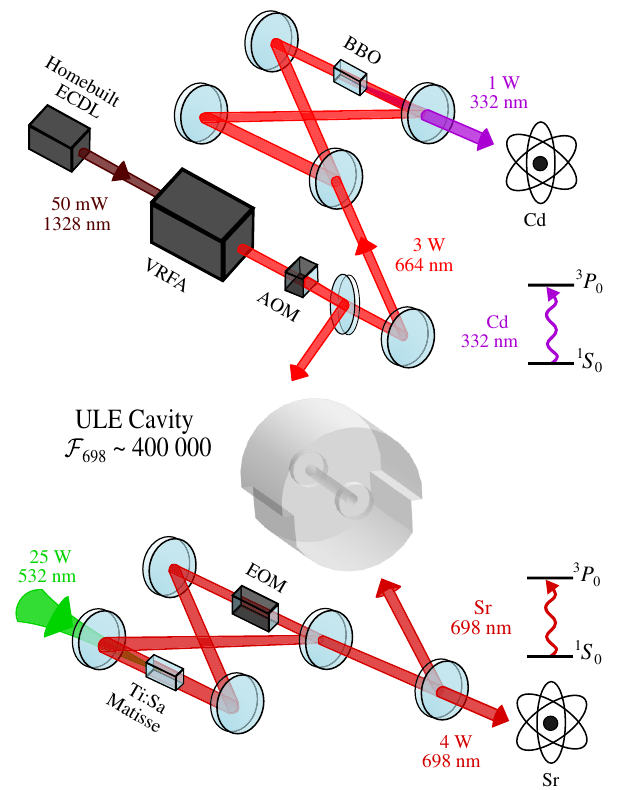
FIG. 4. The setup of the clock atom interferometry laser sources for Sr and Cd at 332 nm and 698 nm, respectively. The laser for Sr is derived from a Ti:sapphire laser with an intracav- ity EOM. For Cd, the laser is a frequency-quadrupled ECDL that is amplified by a Raman fiber amplifier. The lasers can both be locked to the same super-high-finesse ULE clock cavity. See the text for details of the locking